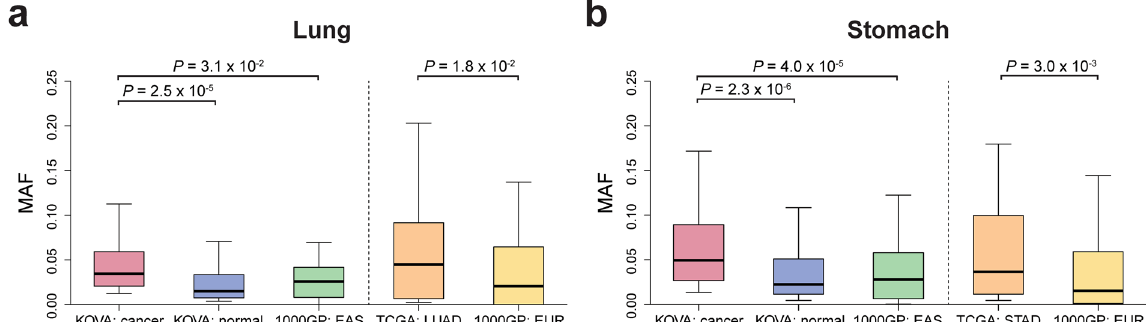
Figure 4. Cancer susceptibility variant distributions in KOVA. Potentially deleterious SNV MAFs extracted from ( a ) lung adenocarcinoma and ( b ) stomach adenocarcinoma tumor-paired normal sets or other public databases were plotted. LUAD: lung adenocarcinoma; STAD: stomach